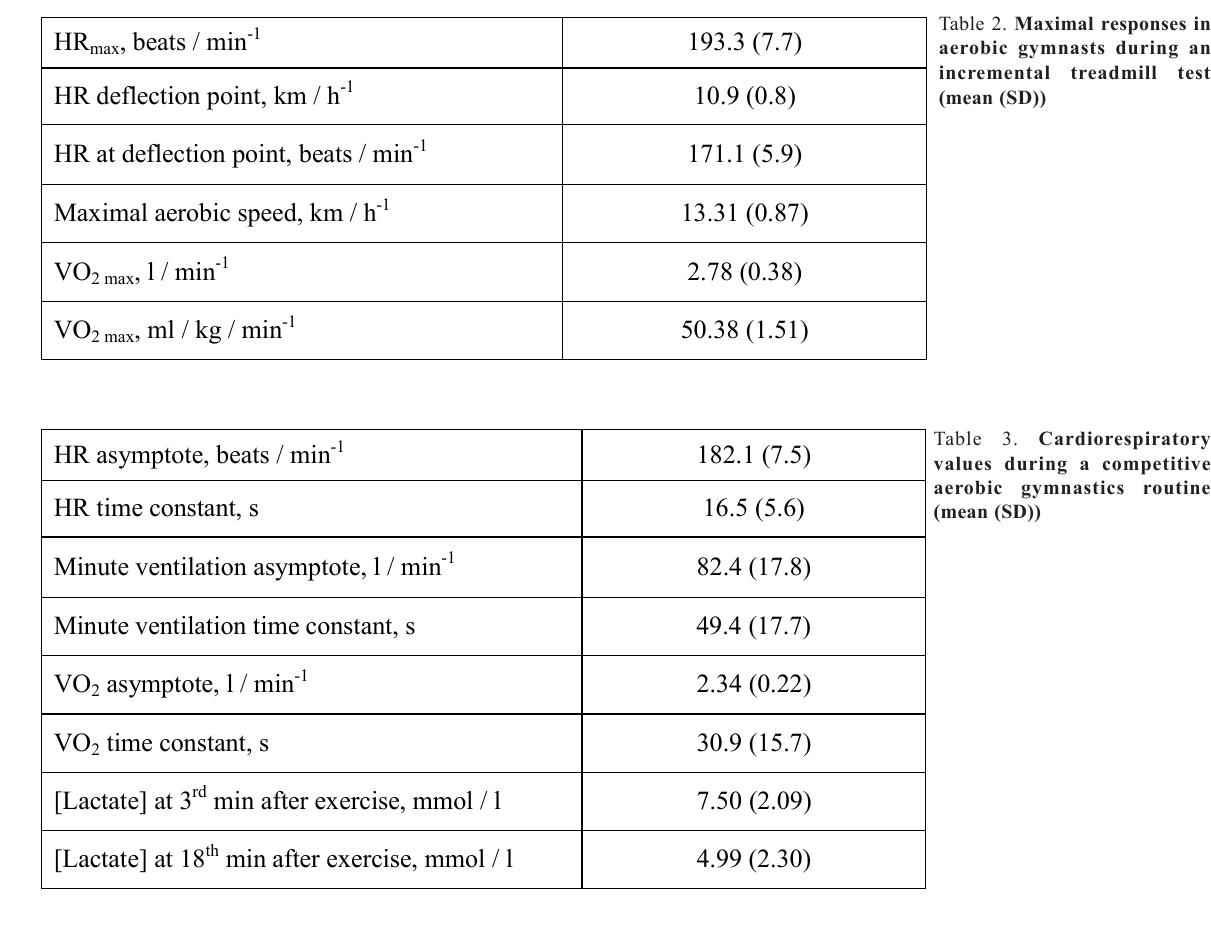
Table 2. Maximal responses in aerobic gymnasts during an